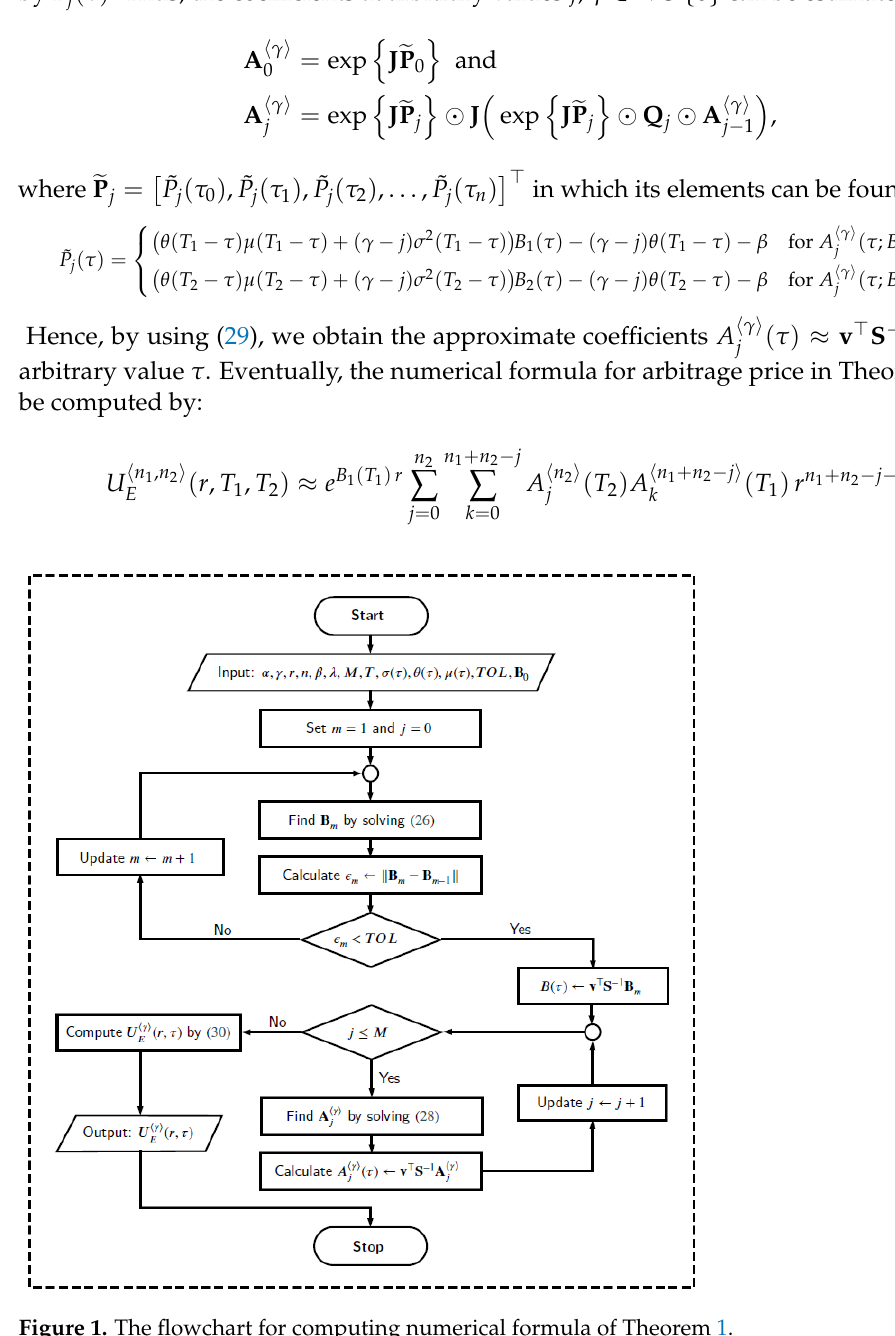
Figure 1. The flowchart for computing numerical formula of Theorem